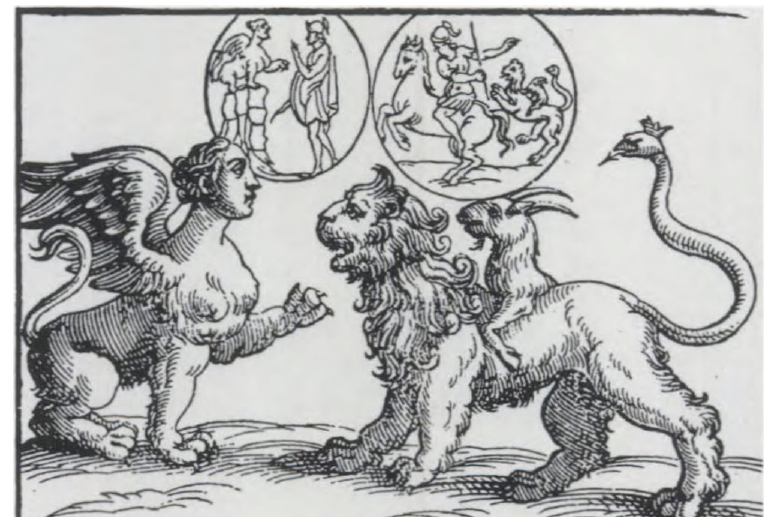
Figure 1. Natale Conti, “Sphinx and Chimaera” [6].